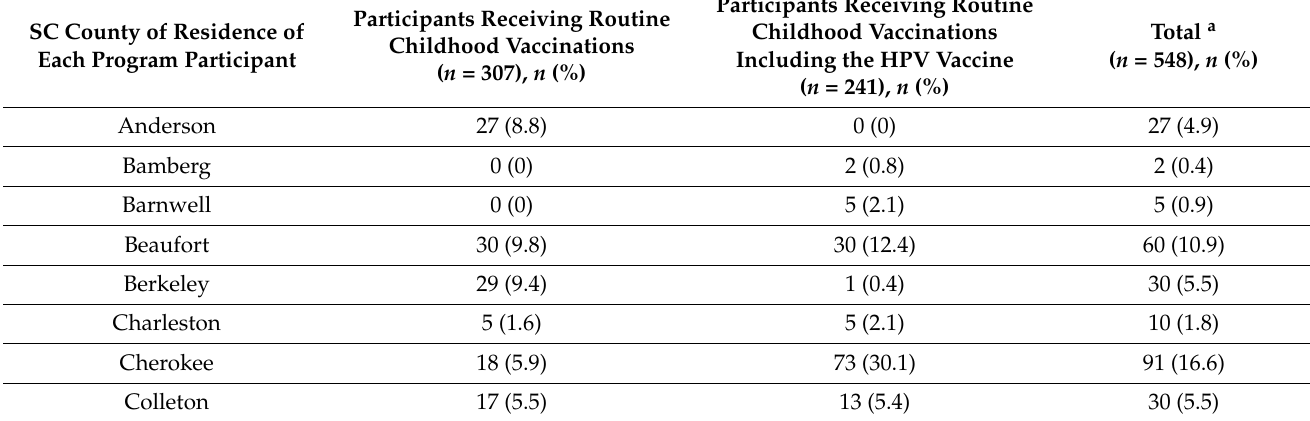
Table 3. County of residence of the HPV Van Vaccination Program participants overall and by receipt of routine childhood vaccinations with or without the HPV vaccine a